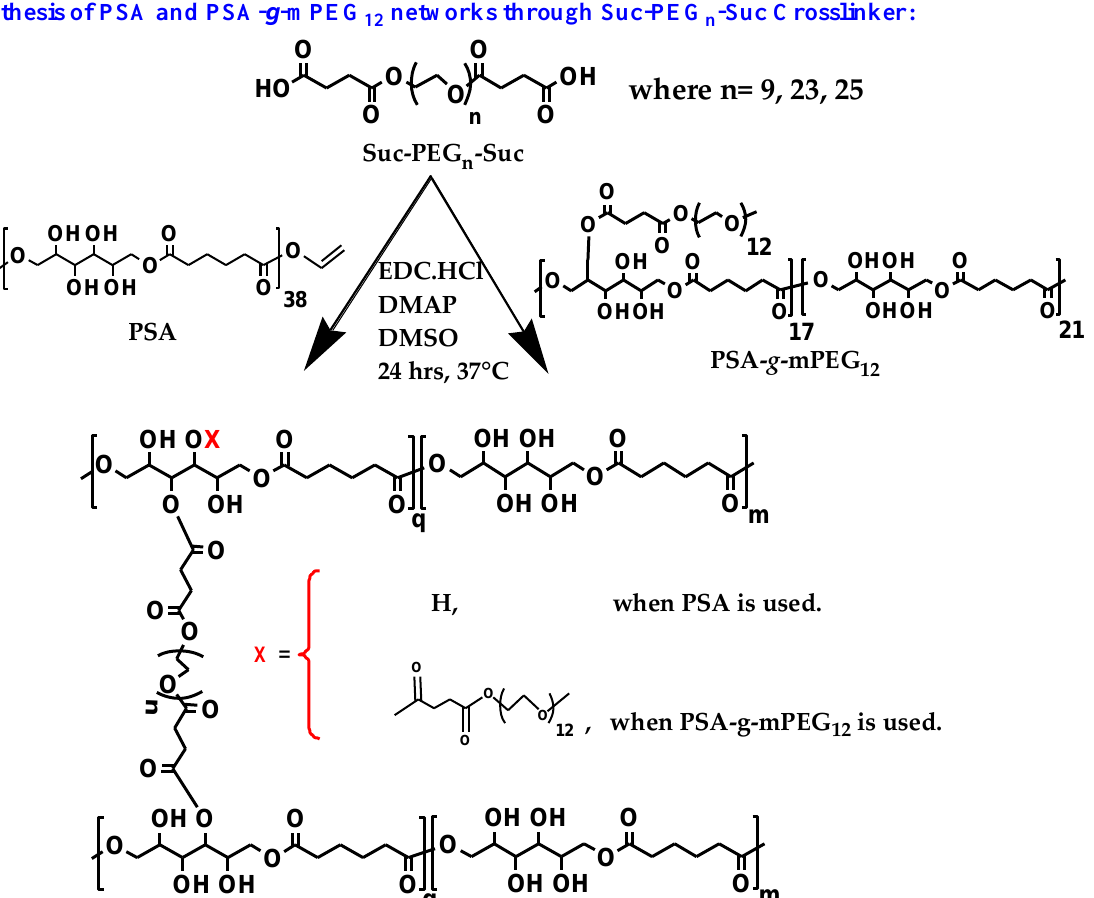
Scheme 1. Synthesis route to network formation from PSA and PSA- g -mPEG 12 .